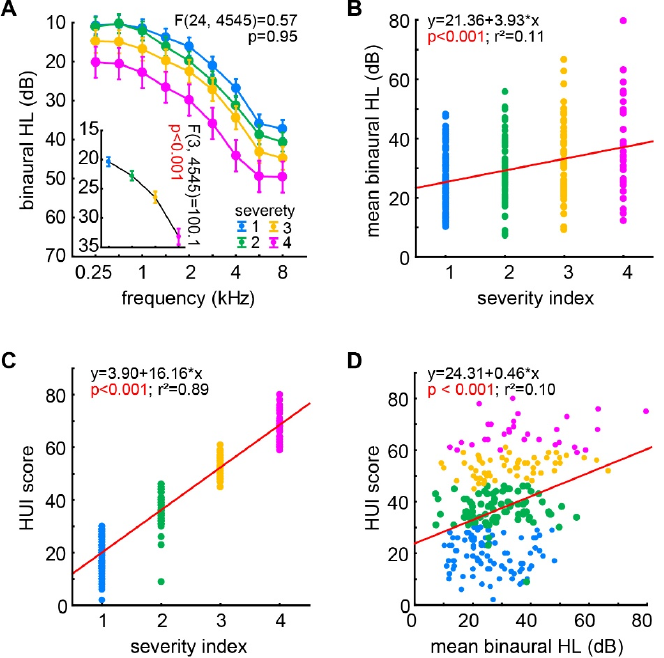
Figure 1. Relationship of HL, tinnitus severity index and HUI score. ( A ) Results of the two-factorial ANOVA of the patients’ binaural HL dependent on the factors ‘frequency’ and ‘tinnitus severity’. Given is the interaction plot of both factors with the F-statistics. The inset depicts the effect of the factor tinnitus severity (averaged over all frequencies). Note that all groups are significantly differ- ent from each other (Tukey post-hoc tests). ( B ) Significant multiple linear regression analysis of the individual mean binaural HL (averaged over all frequencies) and the tinnitus severity index. ( C ) Significant linear regression analysis of the individual HUI score and the tinnitus severity index. ( D ) Significant linear regression analysis of the individual HUI score and the mean binaural HL.